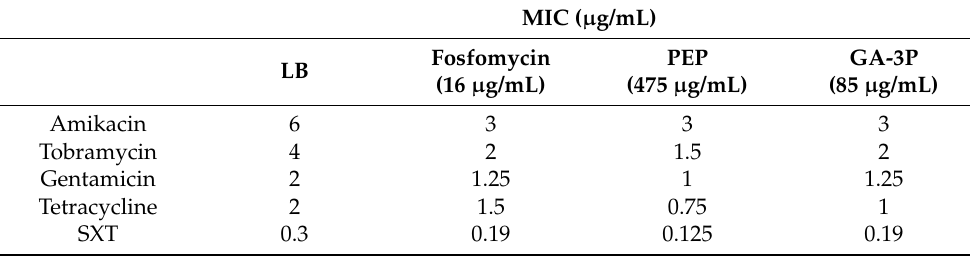
Table 7. Effects of the SmeYZ-inhibitory compounds on the susceptibility of S. maltophilia to